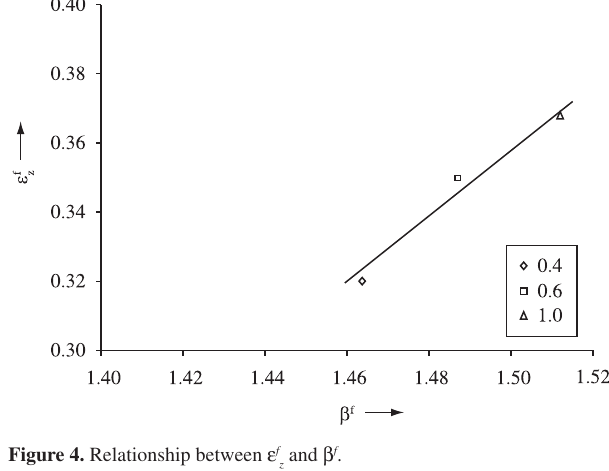
Figure 4. Relationship between e f